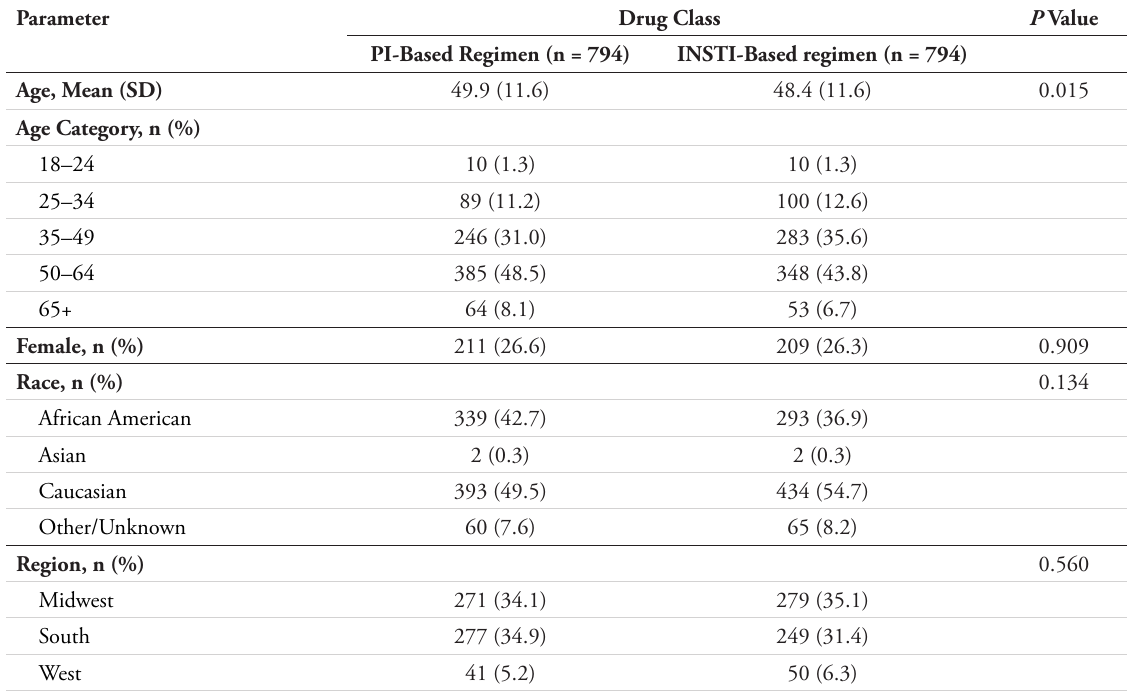
Table 1. Demographic and Clinical